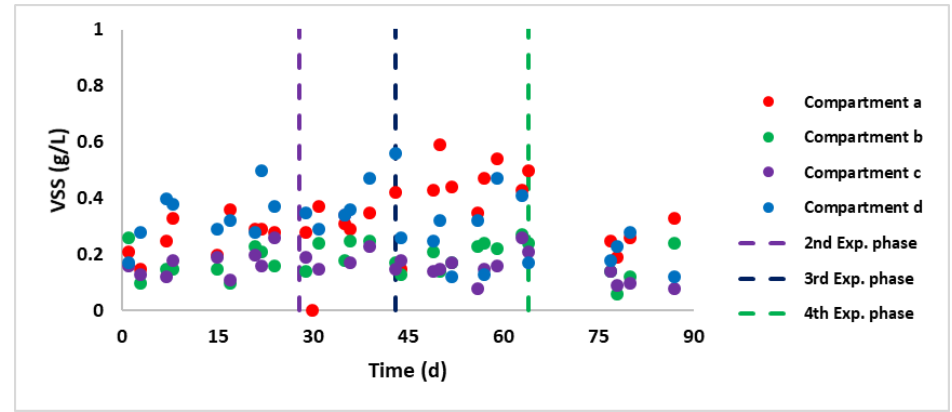
Figure 18 . Daily VSS concentration in the reactor ’ s